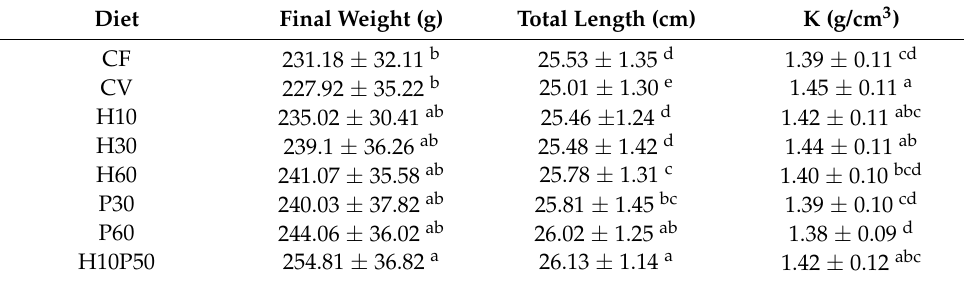
Table 1. Final body weight, total length, and Fulton’s condition factor, K = Weight (g) × 100/Total Length (cm 3 ) of rainbow trout fed the test diets. Within each column, means with different superscript letters are significantly different ( p <